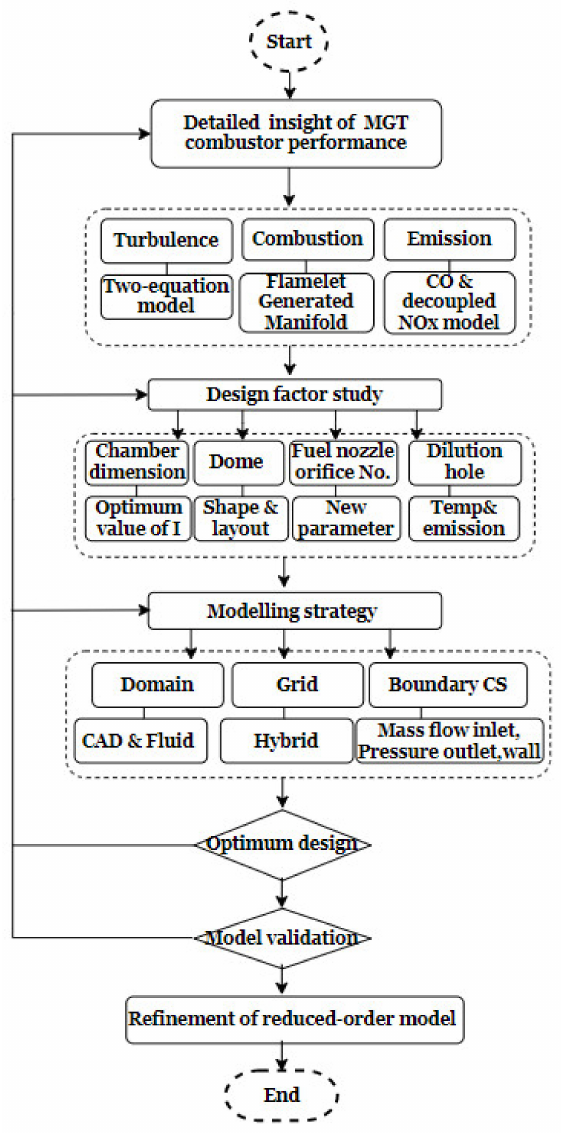
Figure 3. High-fidelity modelling